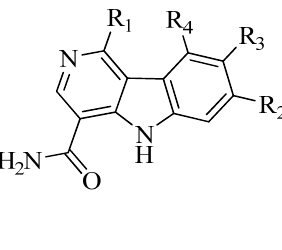
values of newly designed 50